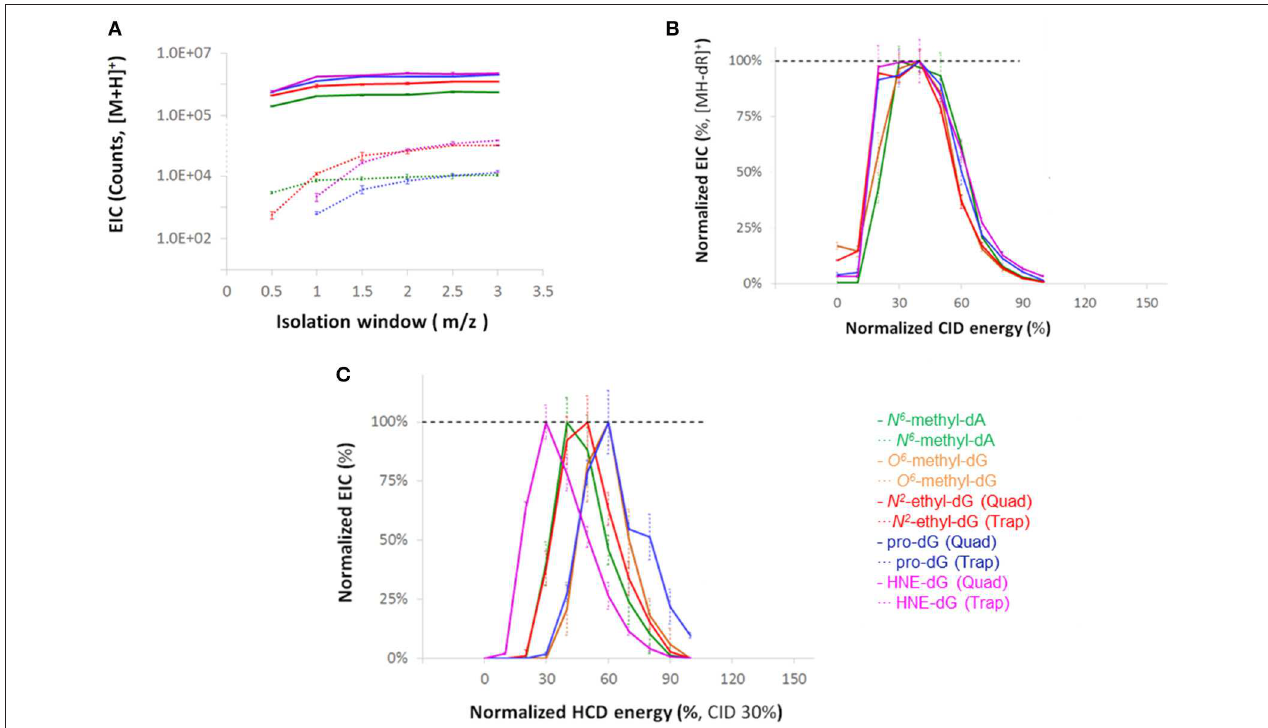
FIGURE 1 | (A) Extracted ion chromatogram (EIC) signal intensity for the four adducts with quadrupole and ion trap isolation as a function of isolation width. (B) Intensities of MS 2 product ions resulting from neutral loss of dR moiety (C) Intensities of base peak ions for MS 3 HCD fragmentation with various collision energies where the [MH-dR] + ions were generated and isolated in the linear trap, at a CID-level of 30% and isolation width of 3.0 m/z .